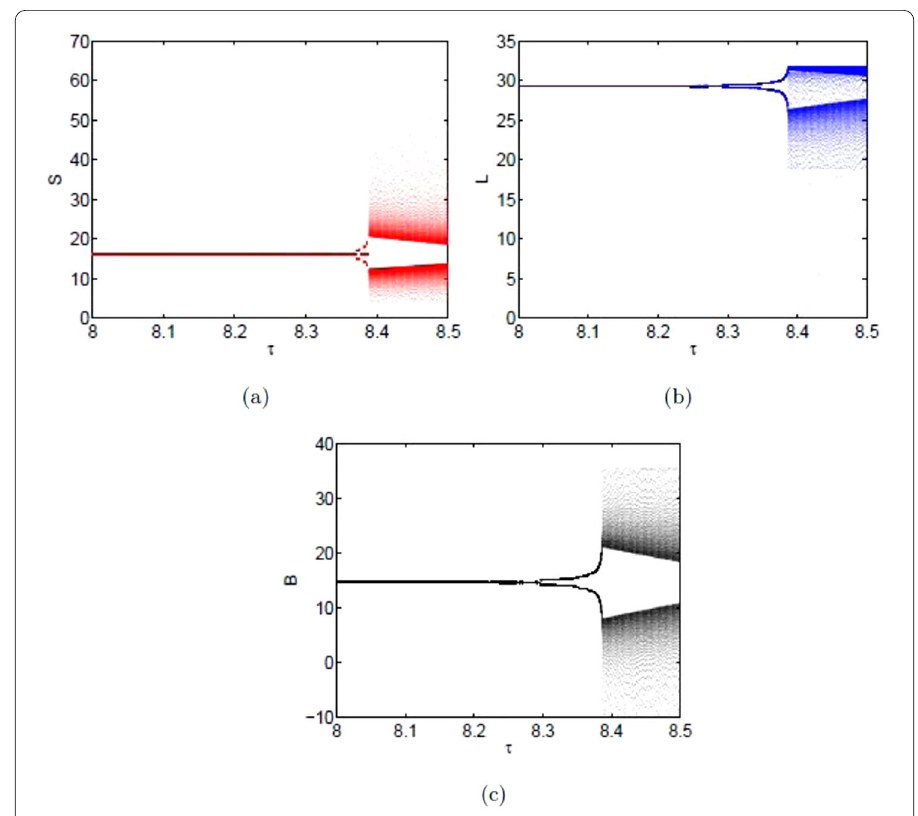
Figure 2 The bifurcation diagram of ( a ) uninfected/susceptible node, ( b ) latent node, and ( c ) breaking-out node with respect to τ . The values of other parameters are as in (31)